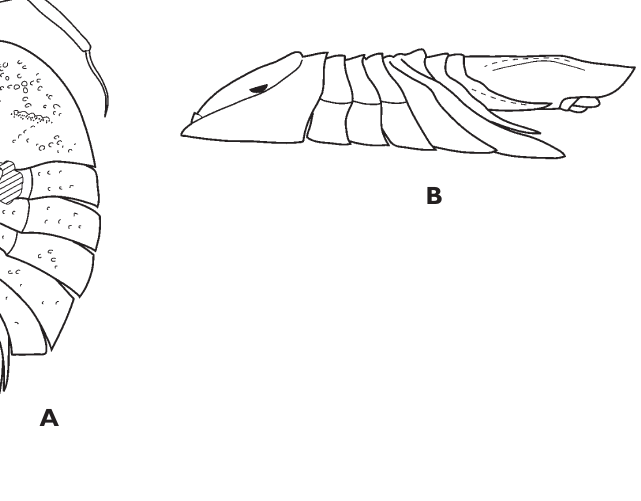
Figure 24. Myopiarolis sp. A dorsal view B lateral